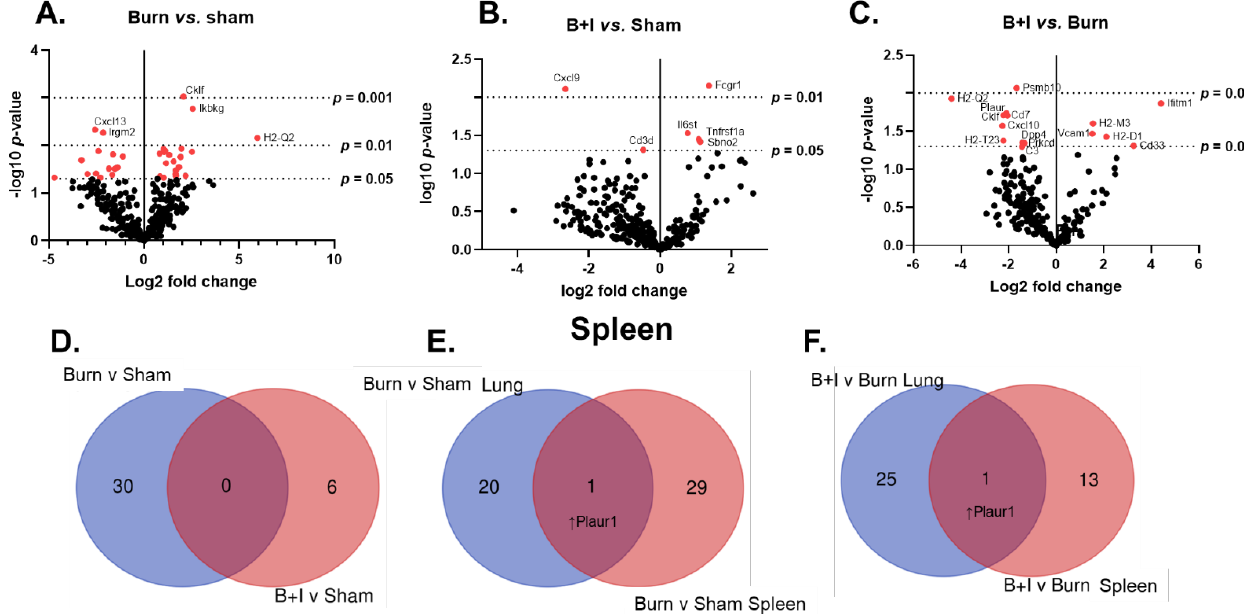
Figure 5. Injury type induces differential spleen (systemic) gene expression. Mice underwent sham, burn, or combined B+I injury, and were sacrificed 24 h post-injury (n = 6 per group). mRNA was extracted from whole lung tissue and NanoString analysis, allowing expression analysis of 770 immune and metabolic genes. ( A – C ) Volcano plots of injury-induced differential gene expression, where red dots signify p < 0.05 (−log10( p -value) > 1.301). ( D – F ) Venn diagrams summarize the number and identity of genes that are impacted in a unique or common fashion to each ( D ) injury type (when quantified vs. sham), ( E , F ) organ studied after ( E ) burn injury alone (when quantified vs. sham) or ( F ) B+I injury (when quantified vs. burn